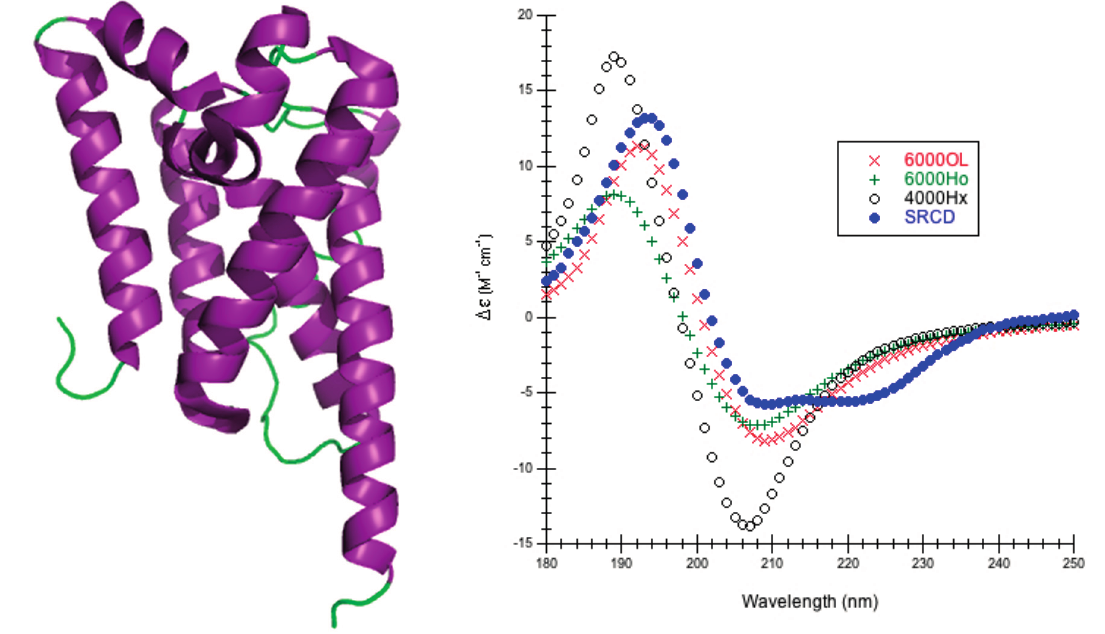
Figure 2. Rhomboid Peptidase. ( Left ) Secondary structure of rhomboid peptidase